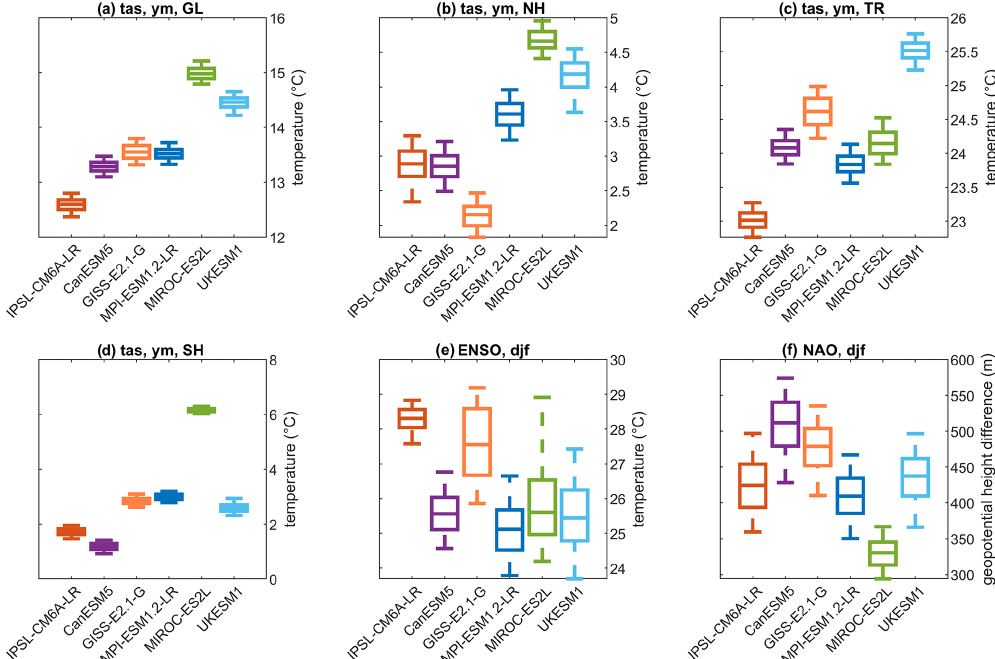
Figure 3. Mean state and variability of unperturbed climates of the participating models. Distributions of selected climatic parameters are shown as box–whisker plots (median, 25th–75th and 5th–95th percentile ranges) for the piControl. Panels (a) – (d) refer to near-surface annual- mean (ym) near-surface air temperature (tas) spatially averaged over the whole globe (GL), the Northern Hemisphere extratropics (NH), the tropics (TR) and the Southern Hemisphere extratropics (SH). Following the VolMIP protocol, NAO is shown as the difference between the 500hPa geopotential height in the two boxes that are used for the calculation of the index (see “Statistical methods and diagnostics” section); ENSO is the average sea-surface temperature in the Niño3.4 region. Both indices are winter-average (December to February) time